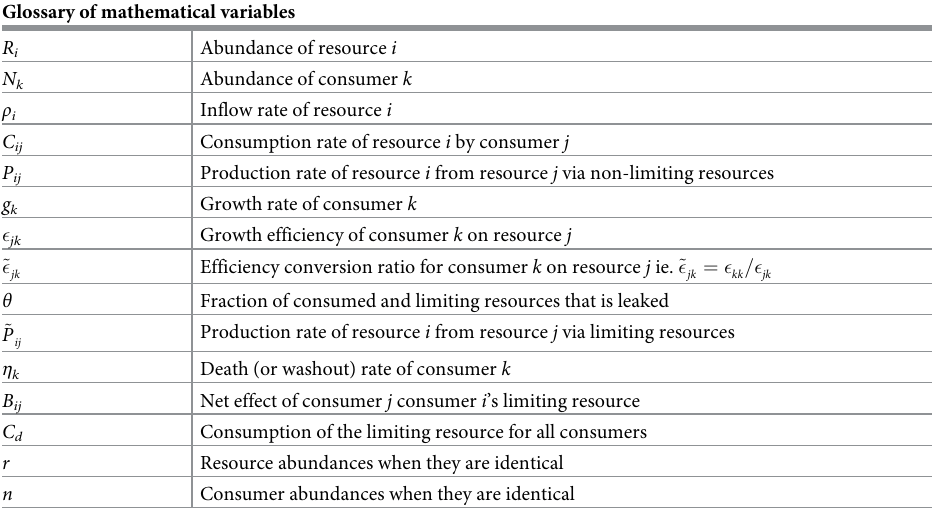
Table 1. Variables in Eq 1 and in our stability criteria with their